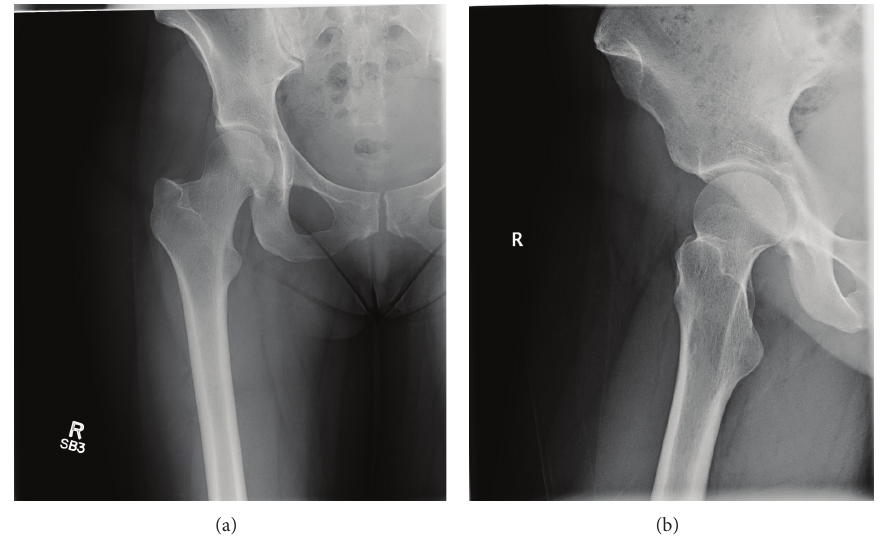
Figure 1: Frontal (a) and internal (b) rotation plain radiographs of the right hip reveal no discrete osseous lesion, cortical destruction, or soft-tissue mass.